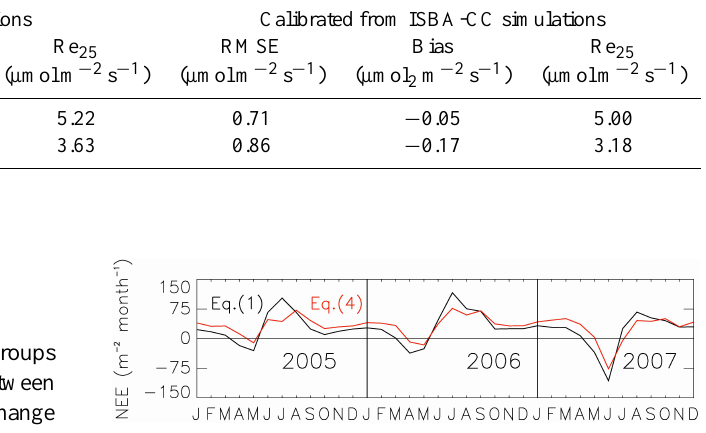
Fig. 2. Monthly NEE (sum of the net CO 2 flux) simulated by ISBA- A-gs using R eco calculated from either Eq. (1) or Eq. (4) (black and red line,